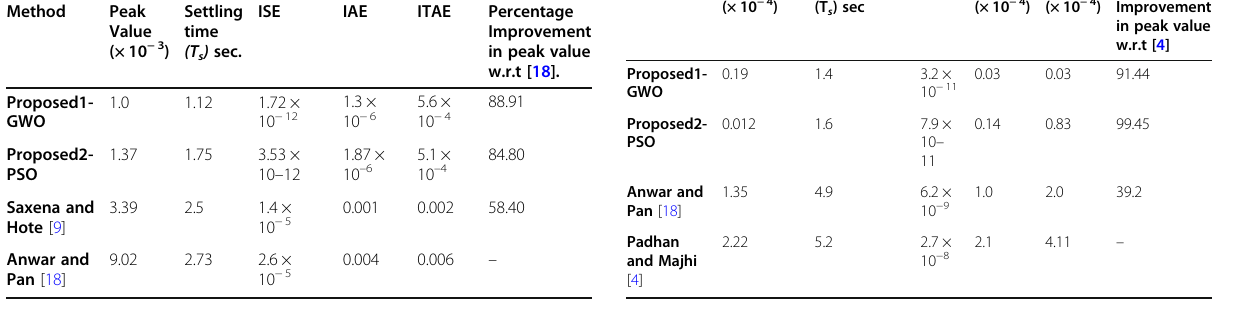
Table 1 Comparison analysis for case study 1 Method